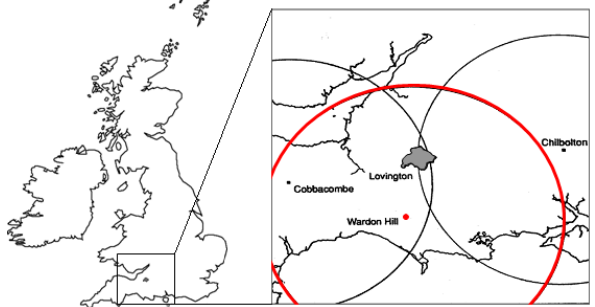
Figure 1 Location of the Brue catchment and the Wardon Hill weather radar Fig. 1. Location of the Brue catchment and the Wardon Hill weather